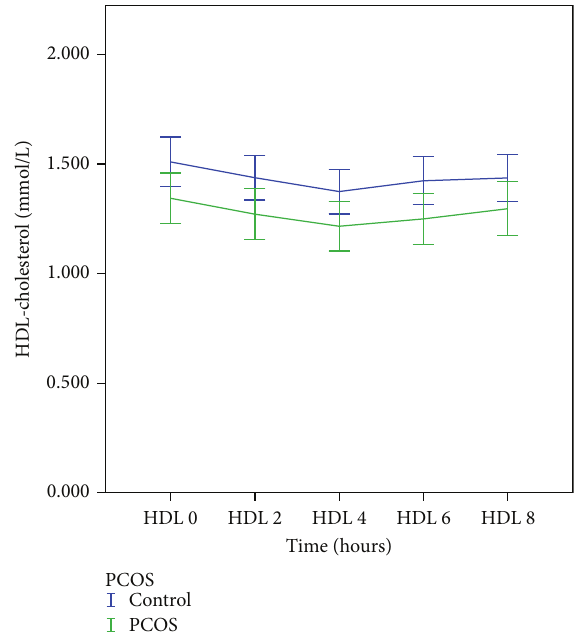
Figure 2: Postprandial HDL-cholesterol response in PCOS and control